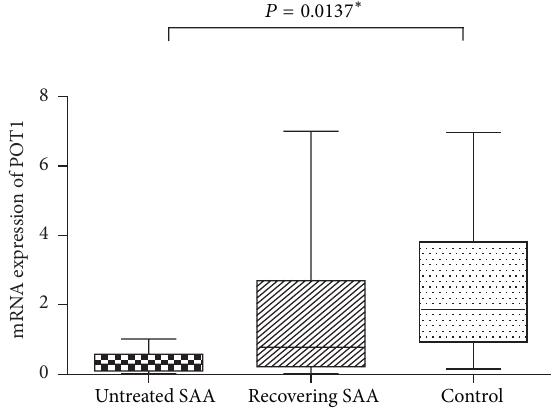
Figure 4: POT1 mRNA expression in different groups.